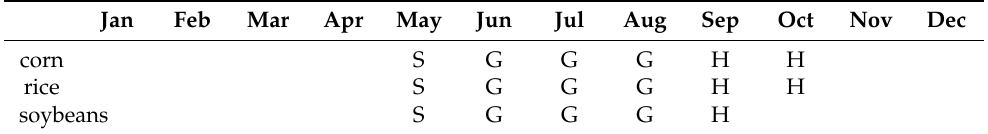
Table 1. Main crop calendar of the study